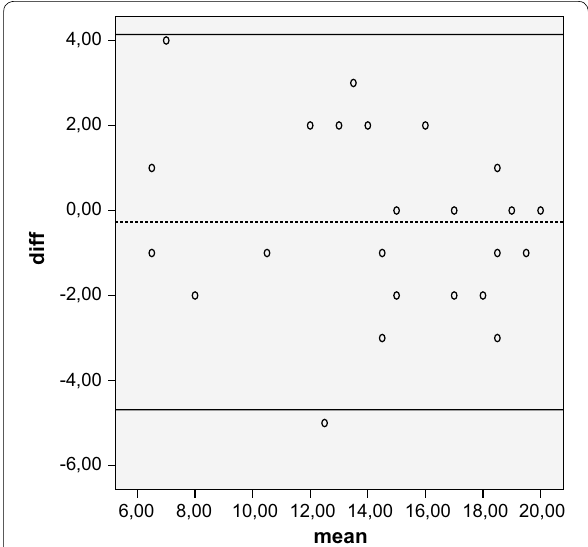
Fig. 2 Bland–Altman plot showing test–retest results for 33 patients completing the Italian version of the Larsen index. The dashed line shows the mean difference; solid lines show the 95 % confidence